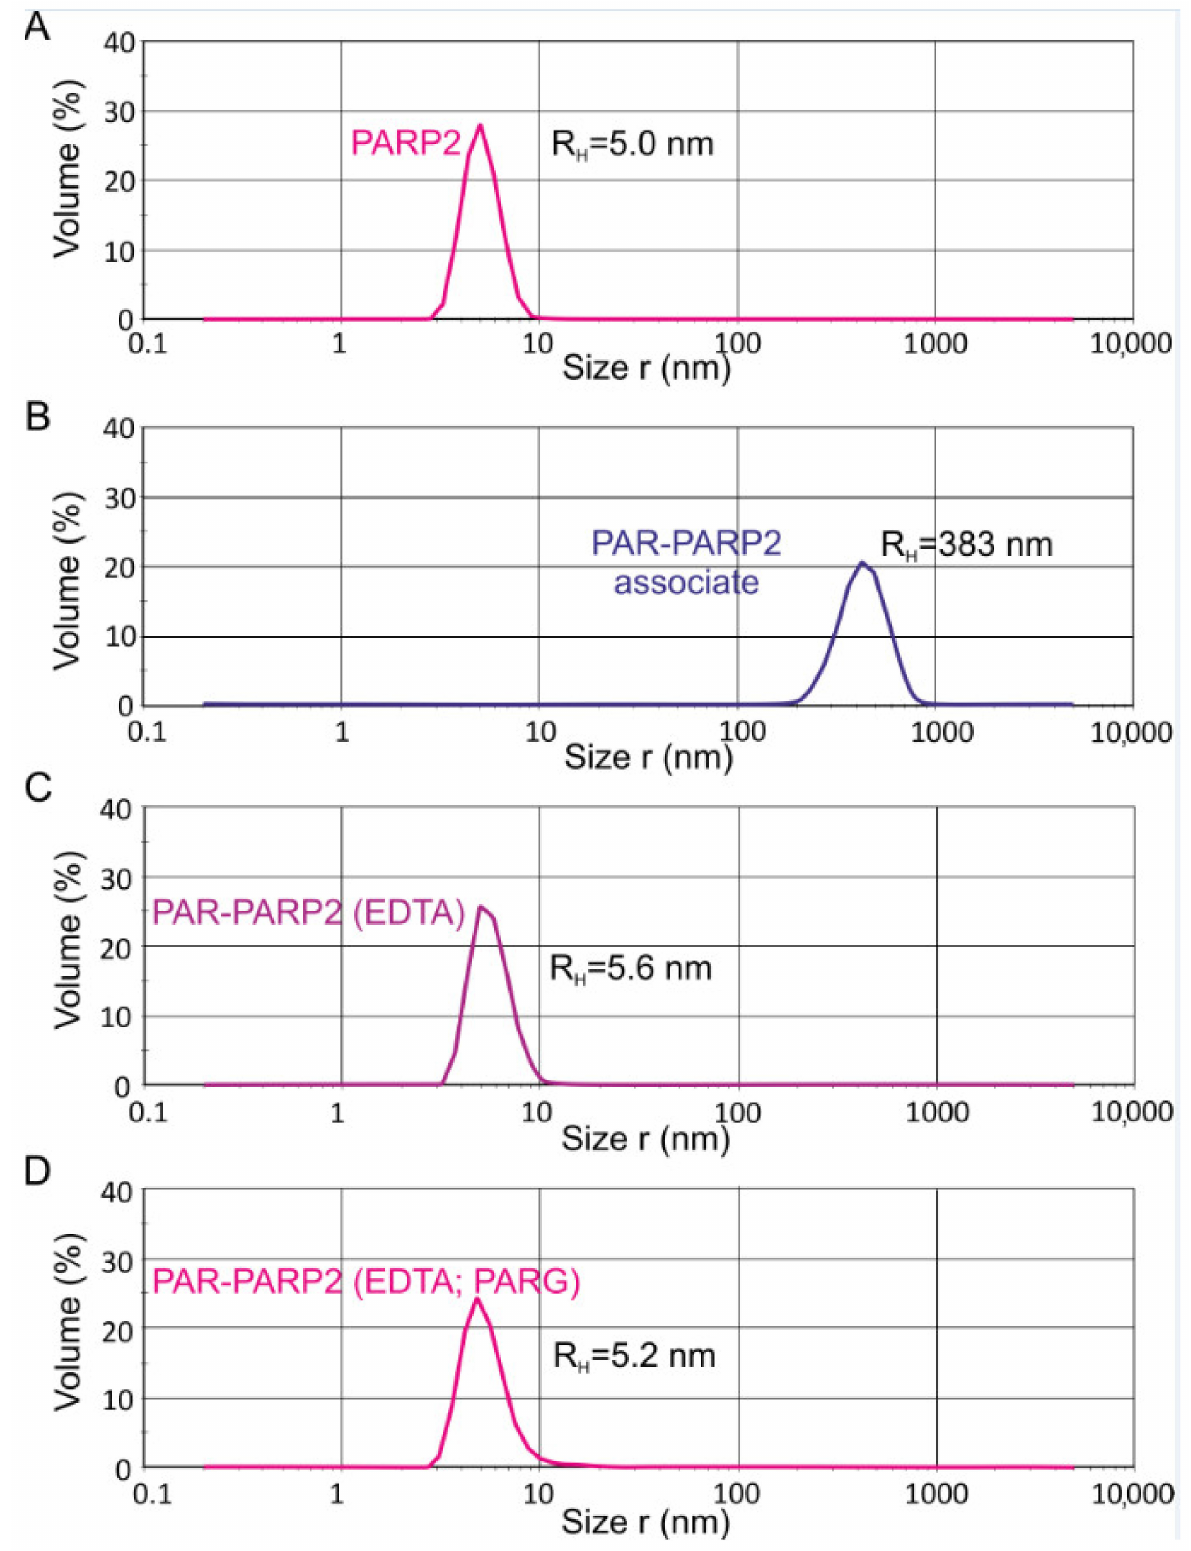
Figure 3. Volume-weighted size distribution profiles for PARP2 protein ( A ) and its PARylated (PAR-PARP2) form ( B – D ). The R H values of PAR-PARP2 were measured directly after 15-min incubation with NAD + and DNA (when the size growth reached the plateau) ( B ) and after the addition of EDTA ( C ) and treatment with PARG ( D